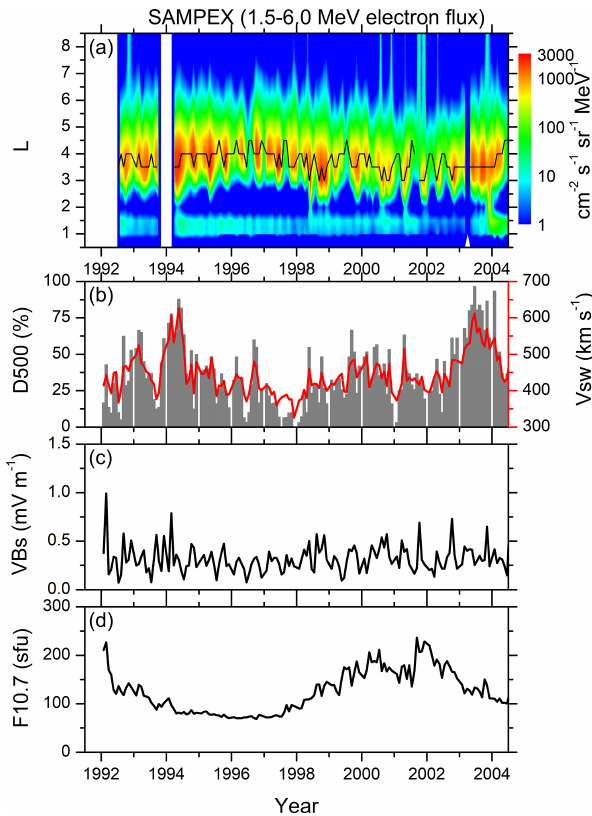
Figure 1. Panel (a) shows the L -shell variation of monthly mean differential 1.5–6.0MeV electron fluxes (the legend on the right shows flux values corresponding to different colors) and L shells corresponding to peak fluxes (black curve), (b) the monthly per- centage of days with peak solar wind speed V sw ≥ 500kms − 1 (the legend on the left) and monthly mean V sw (red curve; see the legend on the right), (c) the monthly mean V B s and (d) F10.7 solar flux for the years 1992 through 2004, respectively, and F10.7 is expressed in solar flux unit (sfu), where a sfu is 10 − 22 Wm − 2 Hz − 1 .